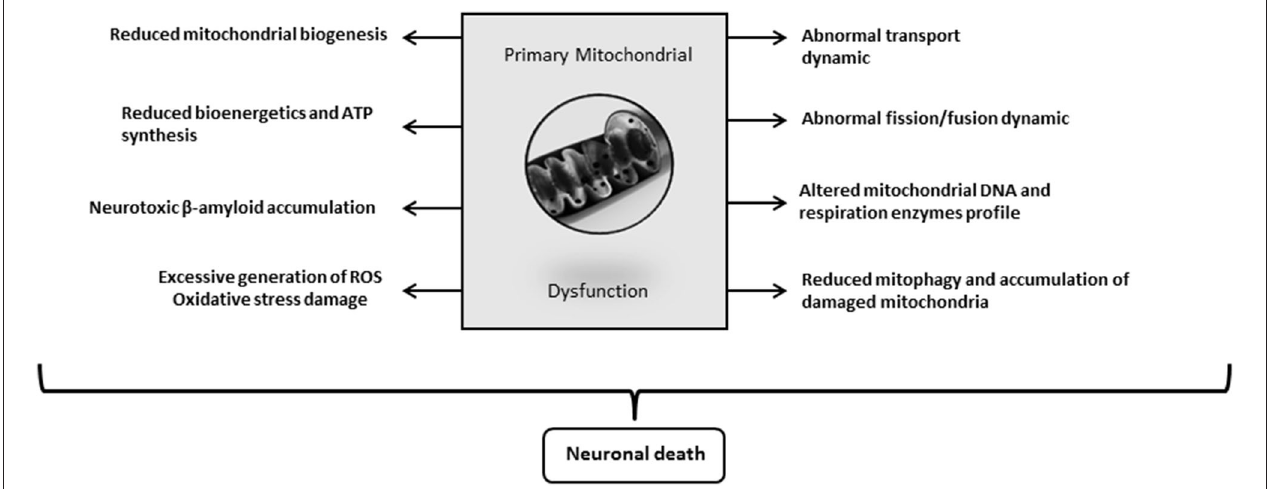
FIGURE 3 | Alzheimer’s disease (AD)-driven primary mitochondrial dysfunction. Although it is still debated “who drives who” along the course of molecular events leading to clinical AD, mitochondrial primary dysfunction is a well-founded hypothesis on the pathogenic cascade of AD. Mitochondrial dysfunction means that bioenergetic derangement is broad enough to trigger and run through a series of critical pathogenic ingredients of AD. A primary defect on mitochondrial physiology could arise from damaged mtDNA, deficit or failure of respiratory enzymes, alterations of oxygen uptake and handling, erroneous or insufficient tagging for a proper organelle purge, etc. The onset of an abnormal mitochondrial function irrevocably leads to neuronal